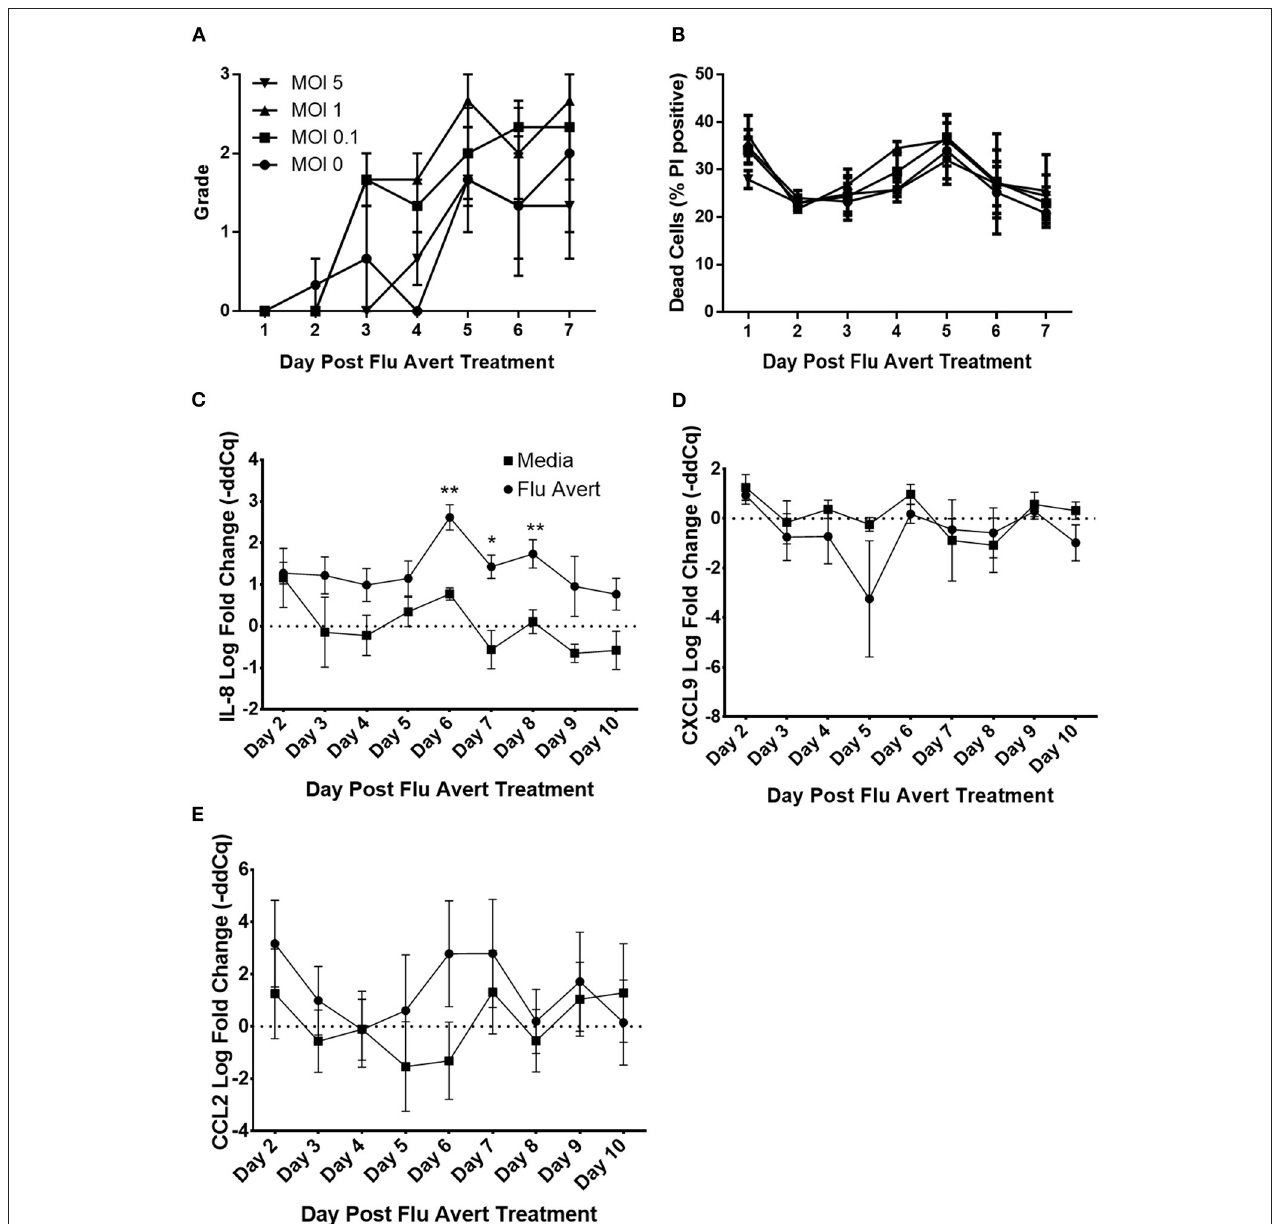
FIGURE 1 | Cell viability and chemokine mRNA expression following Flu Avert treatment in ERECs. (A) Microscopic analysis of EREC cultures. Mean grades from cells ± SEM of three horses following Flu Avert treatment at different MOIs. Grading of cell viability from 0 to 3 is described in Table 1 . (B) Cell viability analysis. Mean percent positive cells ± SEM of three horses at each MOI as determined with propidium iodide staining. Black circle is MOI = 0. Black square is MOI = 0.1. Black upright triangle is MOI = 1. Black upside-down triangle is MOI = 5. (C) IL-8 mRNA expression. (D) CXCL9 mRNAs expression. (E) CCL2 mRNA expression. Values are mean log fold change (–ddCq) ± SEM. Black square represents untreated (media) treated ERECs. Black circle represents Flu Avert-treated ERECs. * p ≤ 0.05 and ** p < 0.01, respectively, between the media and Flu Avert treatment groups.